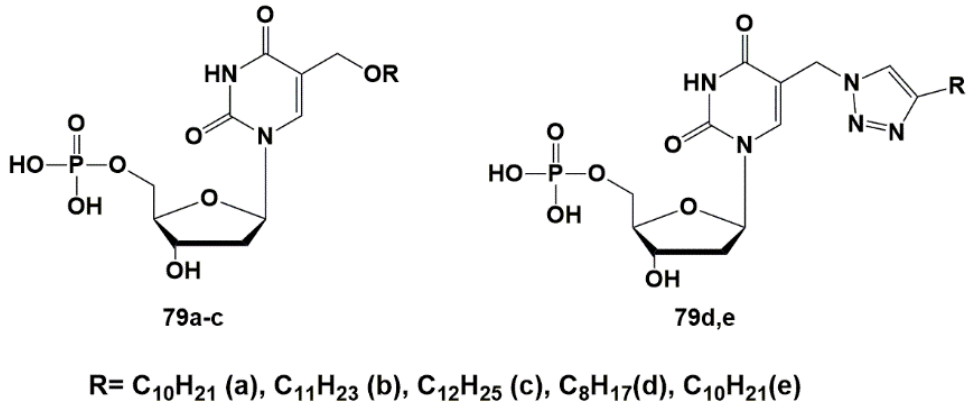
Figure 21. 5 ′ -Monophosphates of 5-oxymethyl and 5-triazolylmethyl-2 ′ -deoxyuridine. Figure 21. 5 (cid:48) -Monophosphates of 5-oxymethyl and 5-triazolylmethyl-2 (cid:48) -deoxyuridine. Synthesized derivatives of 2 ′ -deoxyuridine 5 ′ -monophosphates 79a – c and 79d,e were tested against ThyA and ThyX according to a previously described method [105].